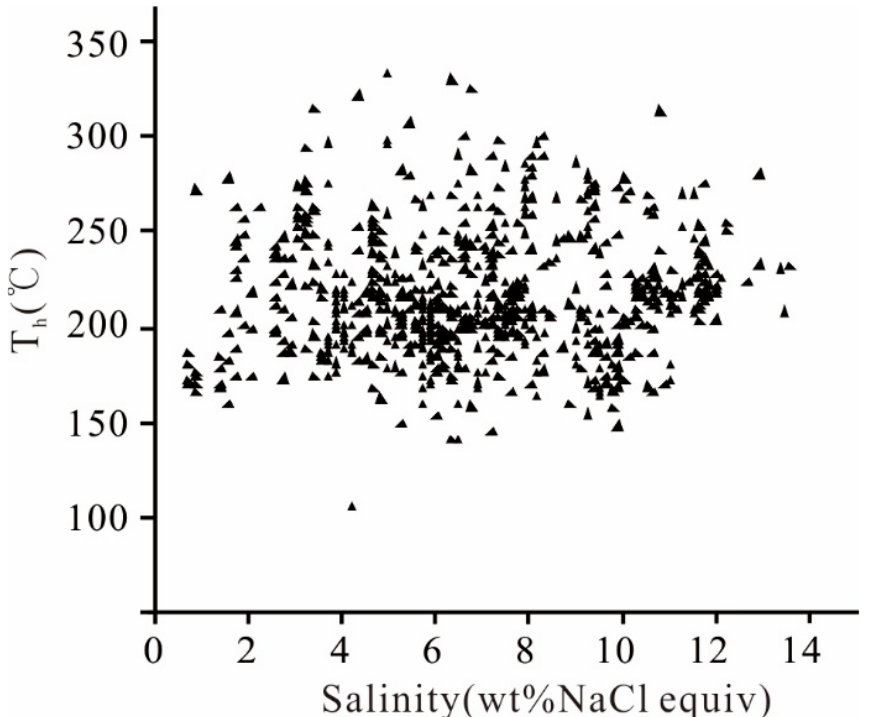
Figure 9. Summary plot of homogenization temperatures and salinities of fluid inclusions.